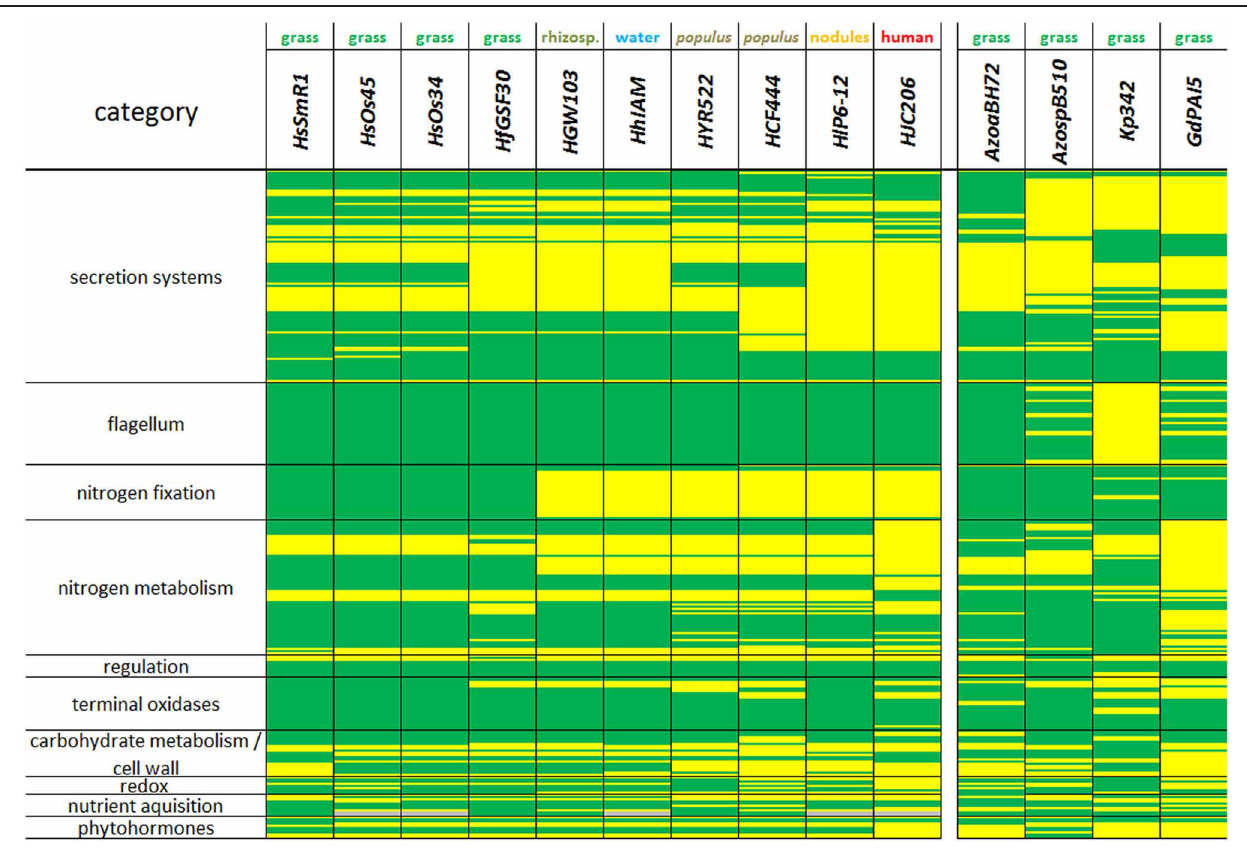
HJC206 , Herbaspirillum sp . JC206; AzoaBH72 , Azoarcus sp. BH72; AzospB510 , Azospirillum sp . B510; Kp342 , Klebsiella pneumoniae